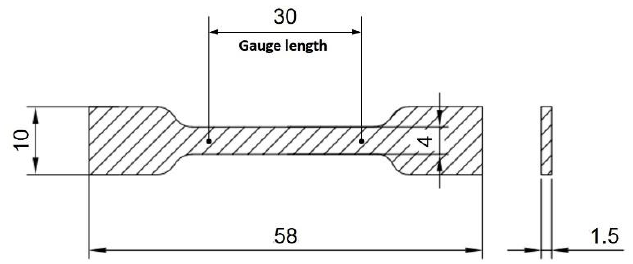
Figure 4. Flowchart of TiO 2 –epoxy nanocomposite preparation.